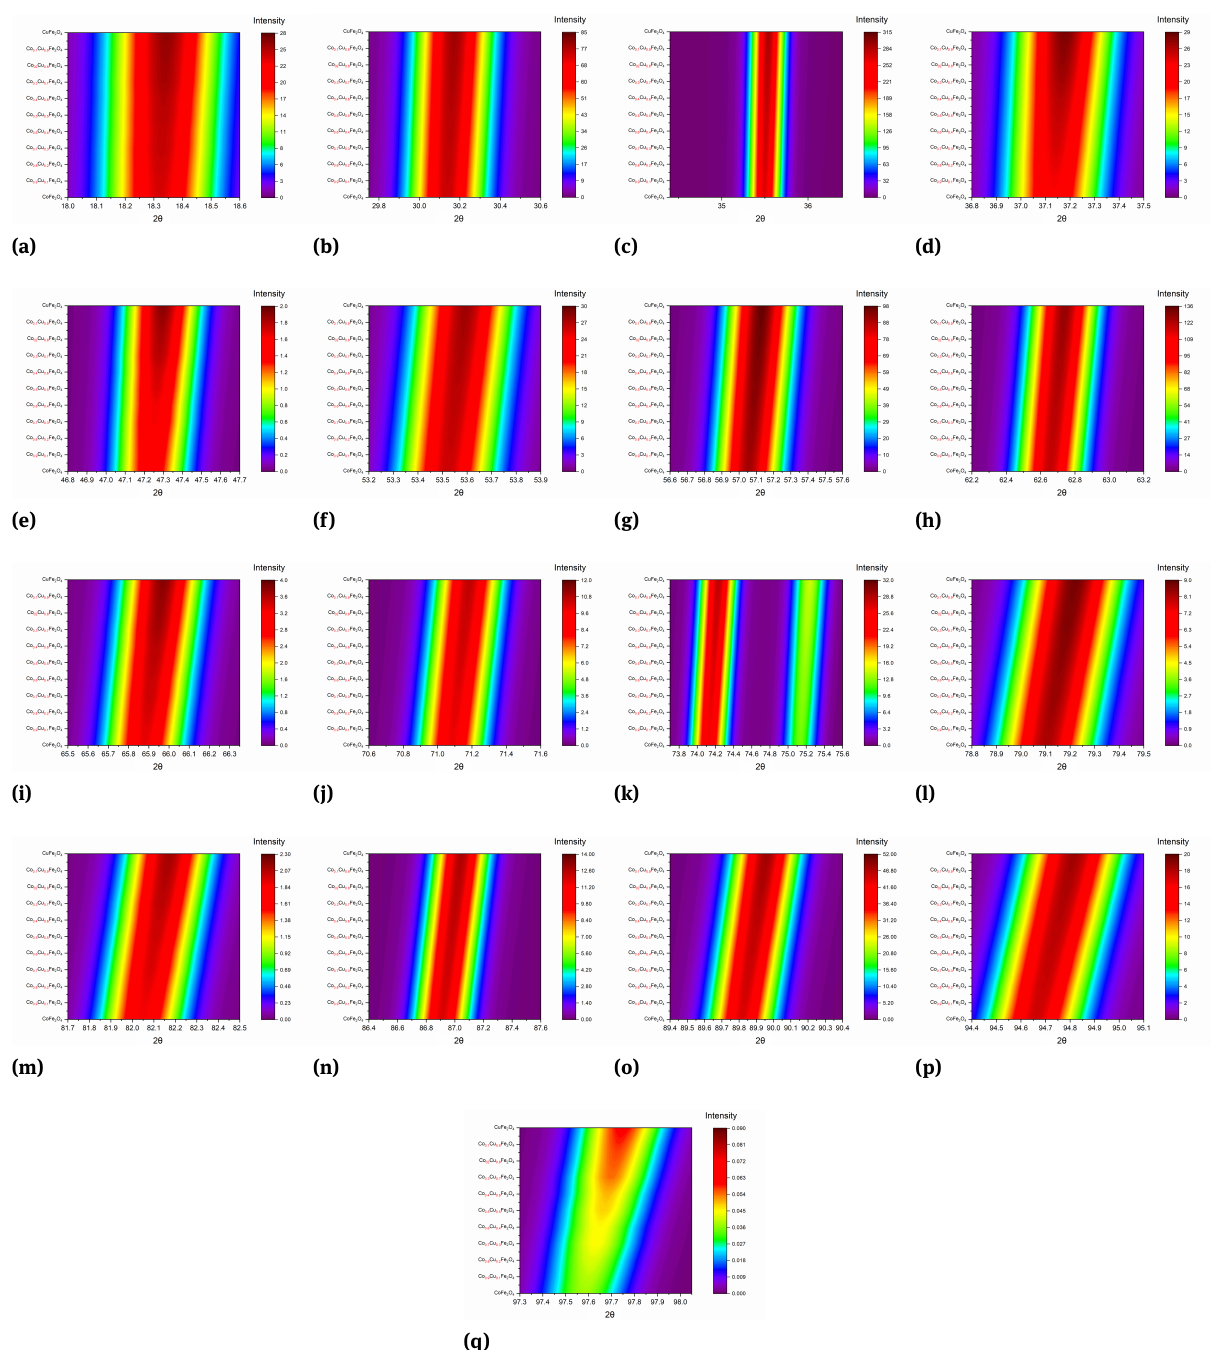
Figure 4: Intensity of for Co x Cu 1-x Fe 2 O 4 peaks (a): 111 peak; (b): 022 peak; (c): 113 peak; (d): 222 peak; (e): 004 peak; (f): 224 peak; (g): 115 peak; (h): 044 peak; (i): 135 peak; (j): 026 peak; (k): 335 peak; (l): 444 peak; (m): 155 peak; (n): 246 peak; (o): 137 peak; (p): 008 peak; (q): 337